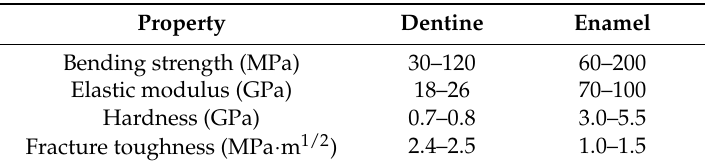
Table 5. Mechanical properties of a natural tooth (data from